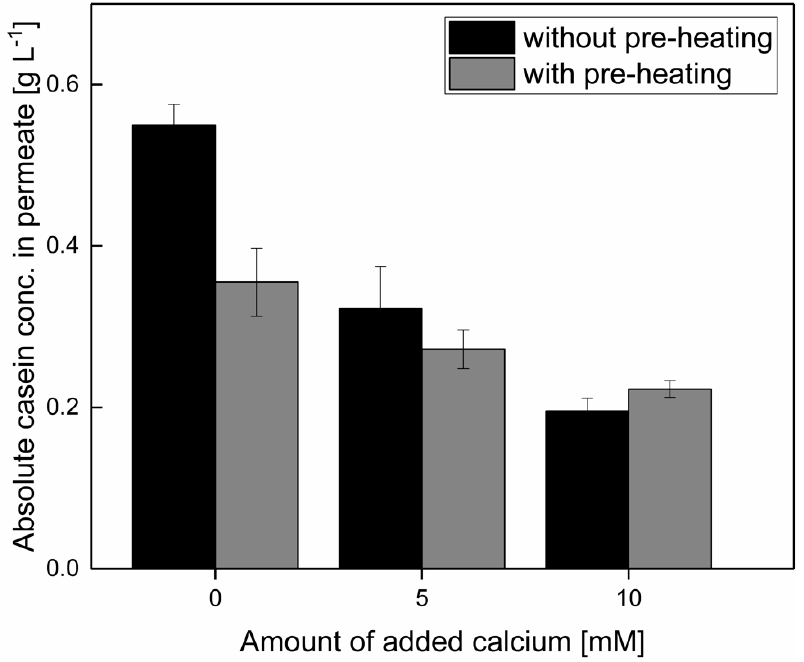
Figure 3. Total casein concentration in the MF permeate after the addition of 0, 5, and 10 mM of calcium.